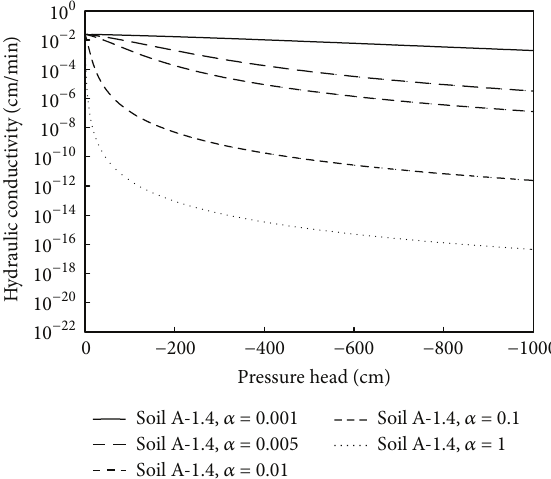
Figure 6: The relation between pressure head and hydraulic con- ductivity for five different values of the 𝛼 parameter used in the simulation model.